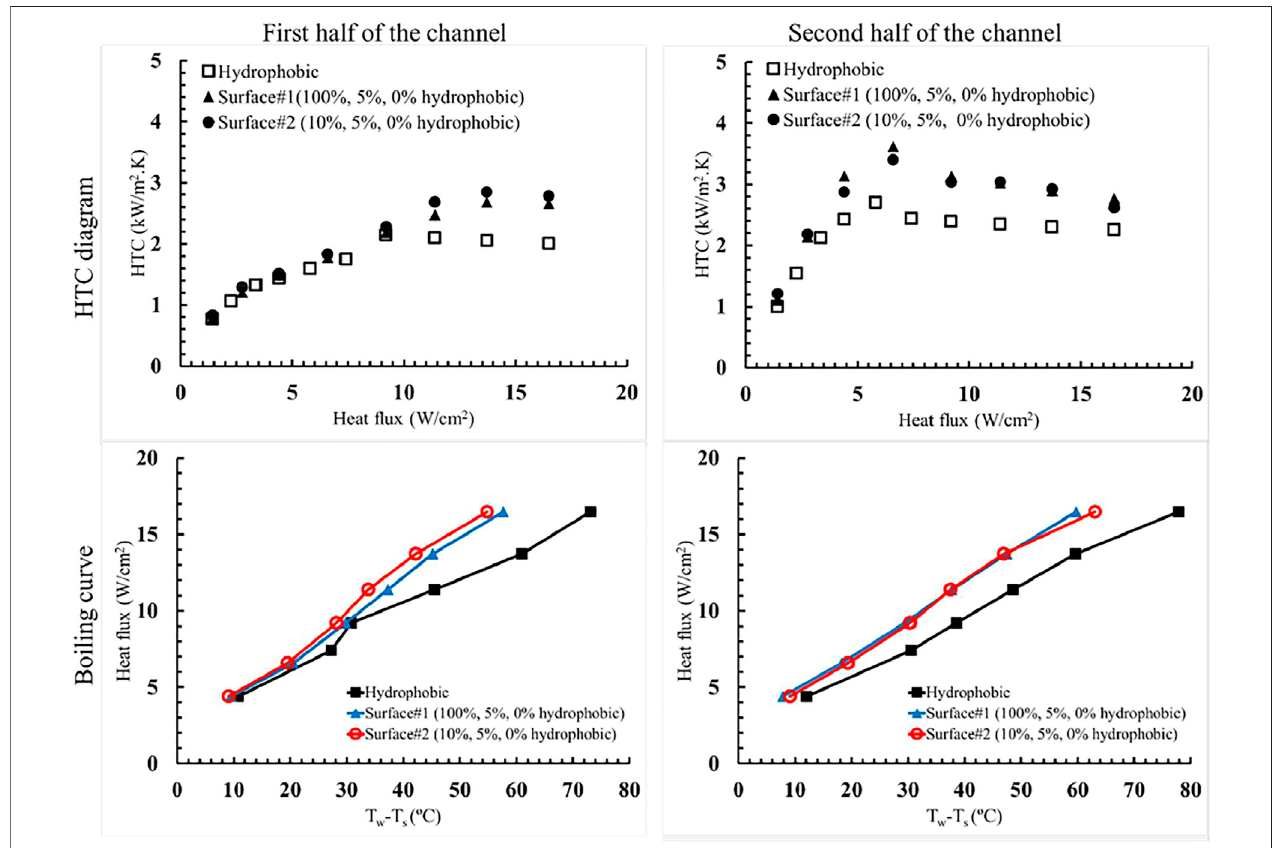
FIGURE 6 | Heat transfer coef fi cients (HTCs) and boiling curves corresponding to the mass fl ux of 130 kg/ m 2 s.